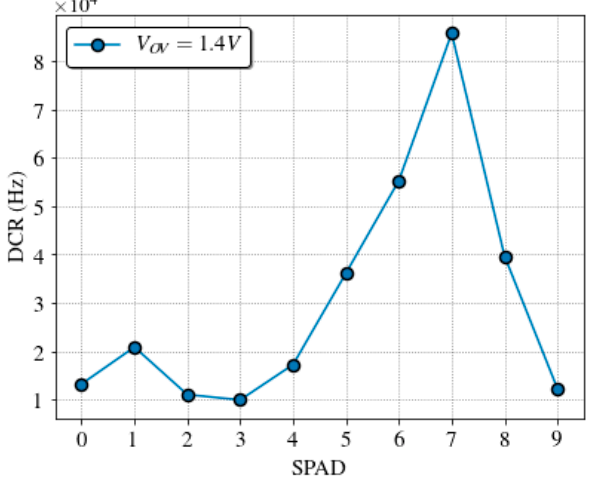
Figure 10. Dark count rate profile (with a maximum relative error of 0.5%) of the used SPAD sensor array at 1.4 V of overvoltage and room temperature.